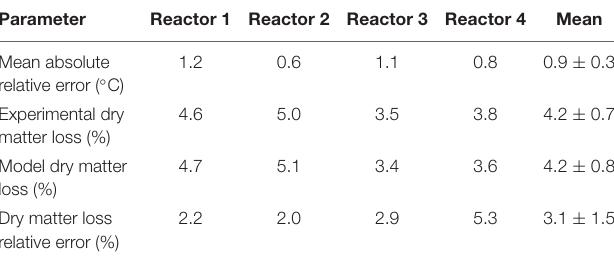
TABLE 4 | Model temperature and dry matter loss error.